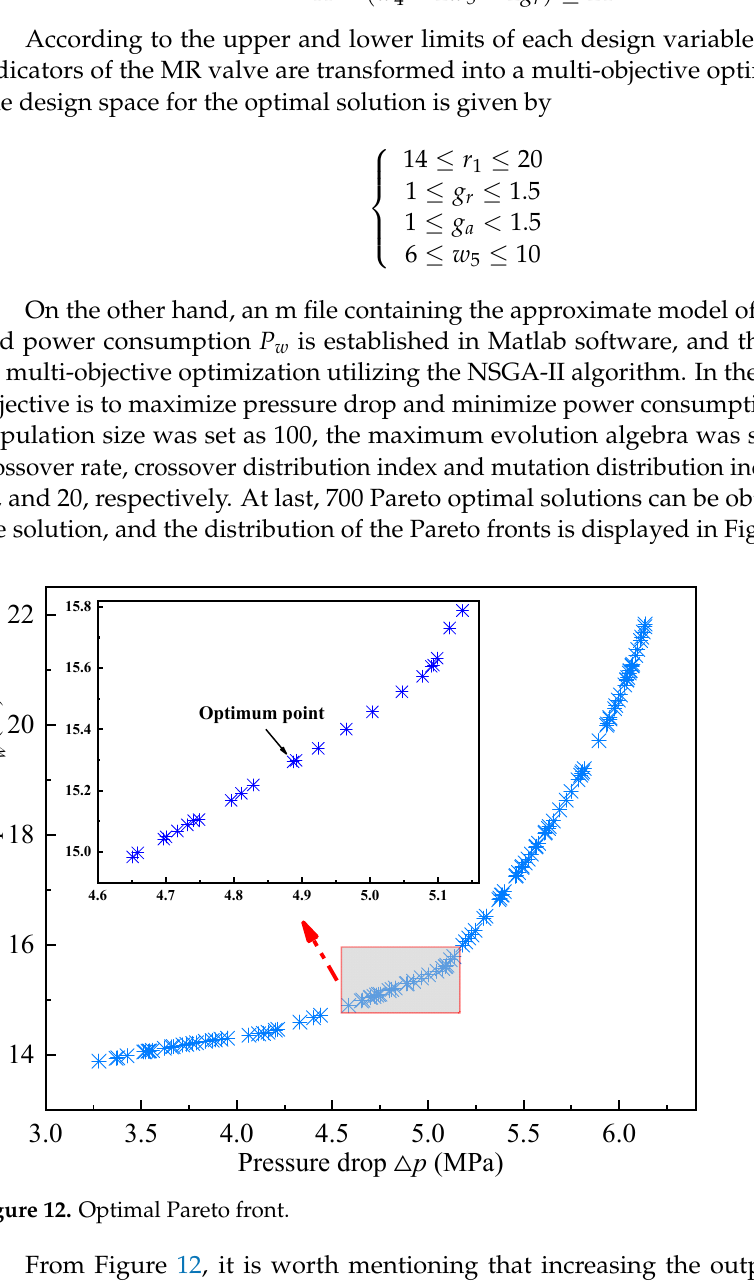
Table 4. Optimization results.